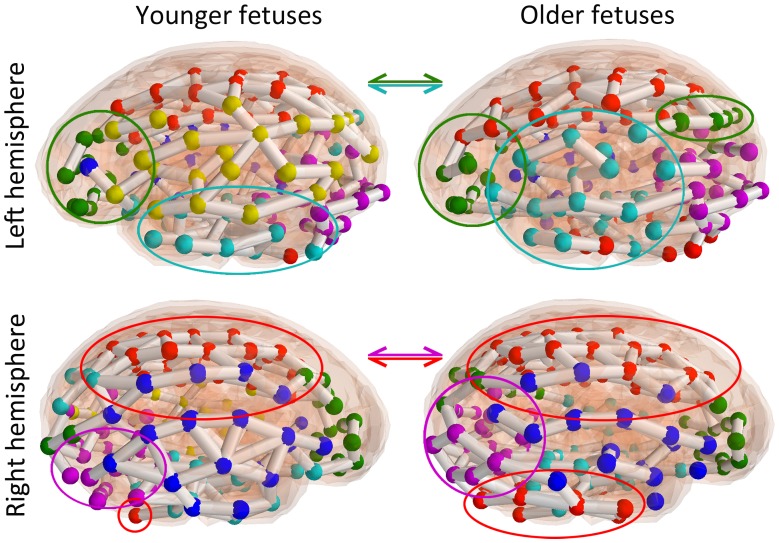
Specific modular changes with development in younger versus older fetuses.Graph visualizations provided in Figure 2 are depicted for the right and left lateral brain perspective and overlaid on a semi-transparent anatomical reference scan. Modules that show significant reconfiguration in older fetuses are highlighted. In older fetuses, sensorimotor cortices (red nodes, red circles) were more functionally connected to regions of the cerebellum and inferior temporal cortices. Prefrontal areas (green nodes, green circles) were more functionally connected to regions of the posterior parietal cortex in older fetuses. A ventral frontal temporal cortex module (teal nodes, teal circles) was present in both groups, but this module became more left lateralized and functionally integrated with inferior frontal and parietal regions in older fetuses. The occipital module (magenta nodes, magenta circles) expanded superiorly to encompass primary and secondary visual cortices in older fetuses.